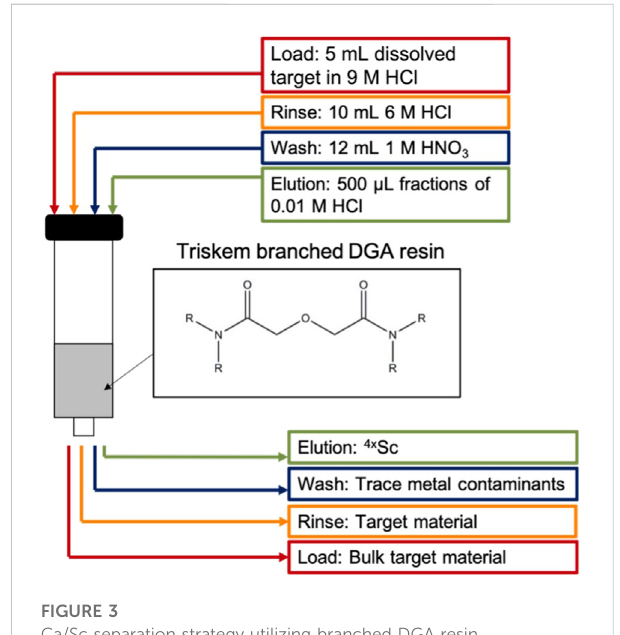
FIGURE 3 Ca/Sc separation strategy utilizing branched DGA